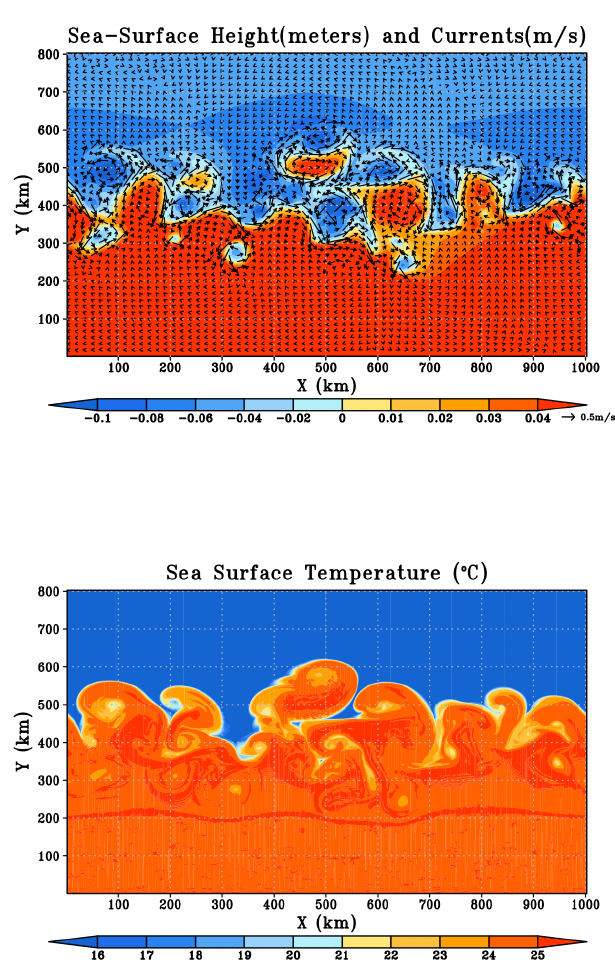
Figure 9. The model results after 39 days of simulation. For the top figure, the colour shading is the sea-surface height (SSH), and vec- tors are ocean currents. For the bottom figure, the colour shading is the sea-surface temperature (SST). Several warm and cold eddies are generated in the middle of the domain where the SST gradient is largest; their scales are determined by the Rossby radius of defor- mation.